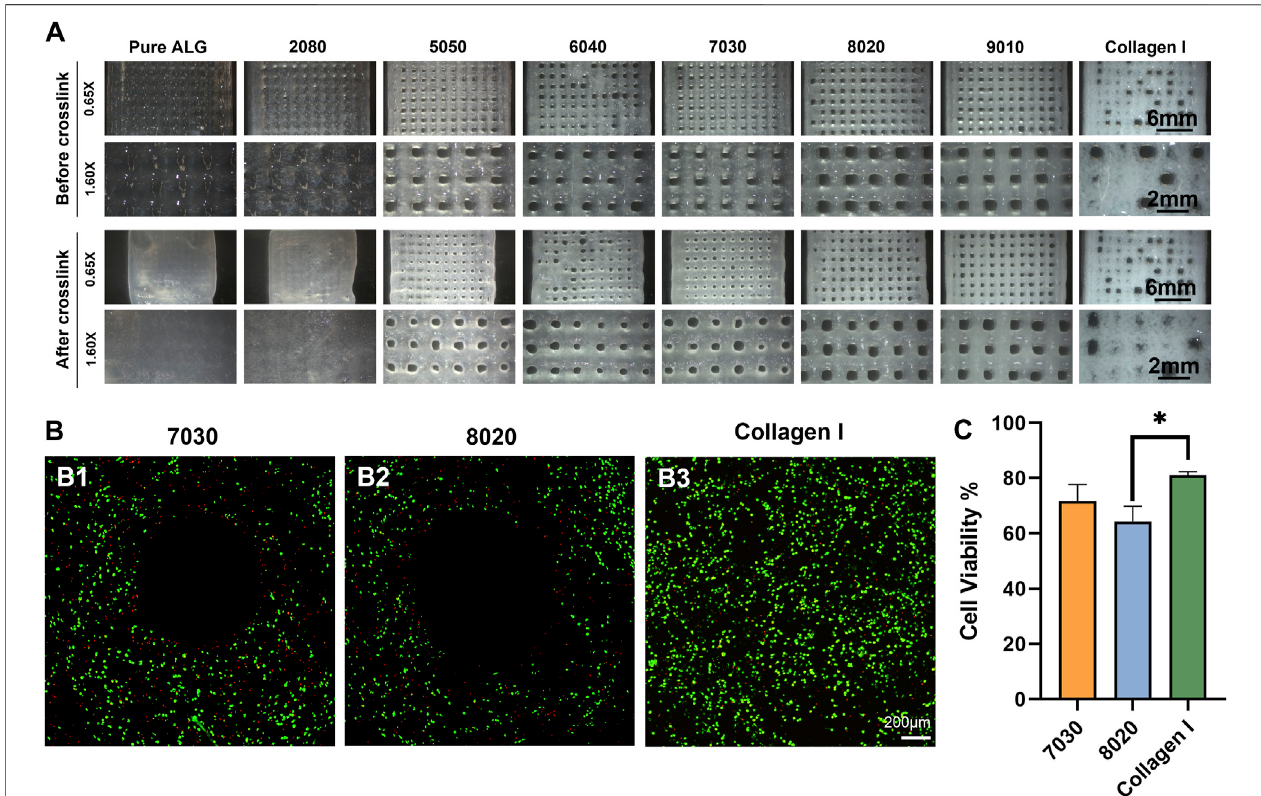
Filament Diameter